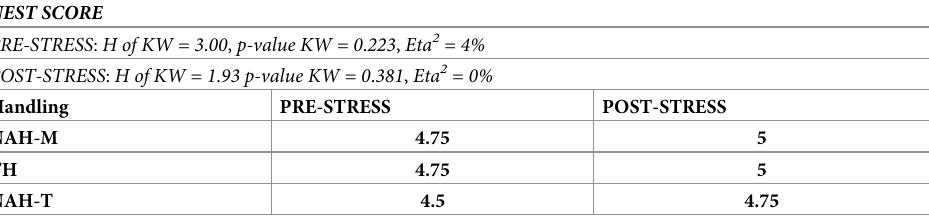
Table 5. Nest score increased in 24 hours in all experimental groups, both before and after R&L stress test, sug- gesting that 15 minutes of acute R&L did not affect nest building ability. In particular, before stress test, 24 hours after nesting material availability, TH mice displayed a score of 4,75, NAH-T a score of 4,5 and NAH-M a score of 4,75 (H of KW = 3.00, p-value KW = 0.223, Eta 2 = 4%). After stress test, 24 hours after nesting material availability TH mice displayed a score of 5, NAH-T a score of 4,75 and NAH-M a score of 5 (H of KW = 1.93 p-value KW = 0.381, Eta 2 =